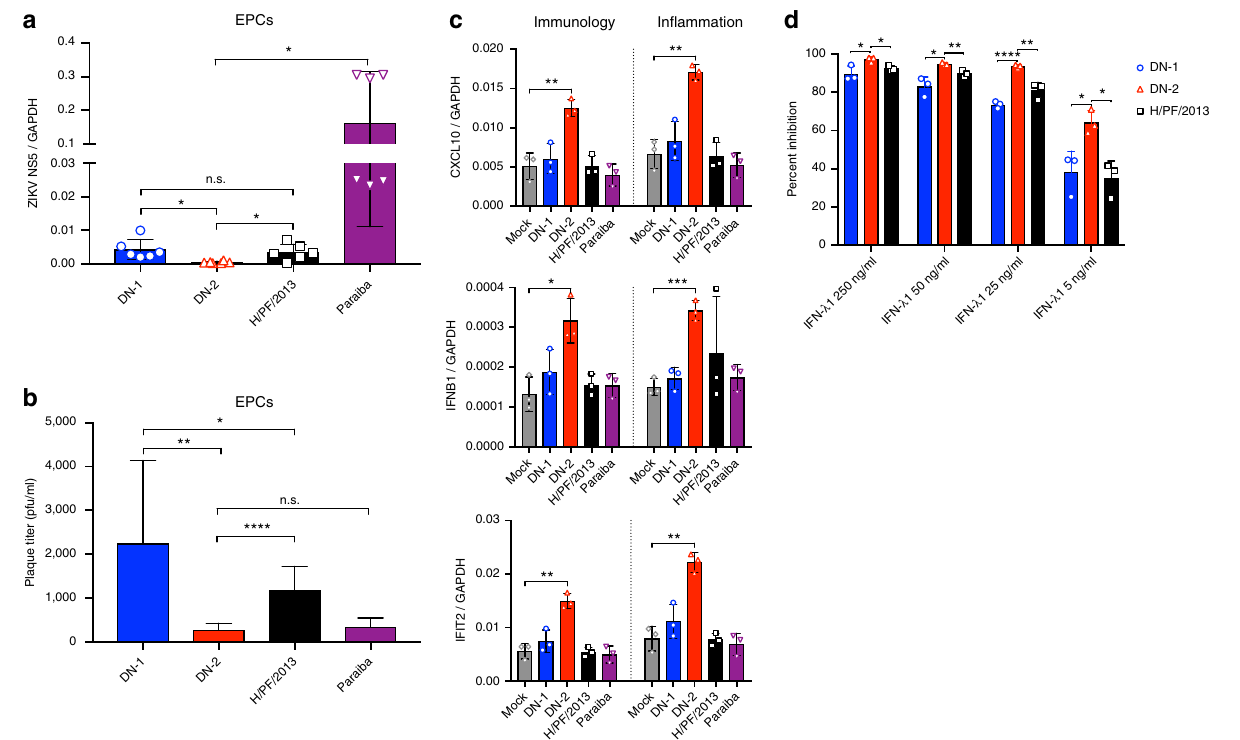
Fig. 5 Attenuated infectivity on endothelial progenitor cells is accompanied by innate immune activation and interferon sensitivity. Viral replication of different ZIKV strains in human embryonic stem cell-derived endothelial progenitor cells (hESC-derived EPCs) was determined by a qPCR ( n = 6) and b plaque assay ( n = 9) (results are combined from three experiments). c NanoString nCounter analysis was performed on infected EPCs at 24 h post infection ( n = 3) using both the Immunology and In fl ammation prebuilt panels. Counts obtained for CXCL10, IFNB1, and IFIT2 were normalized to GAPDH counts. d Percent inhibition of virus replication as determined by viral RNA qPCR on Vero culture supernatant after 48 h of infection with co-treatment at different concentrations of IFN- λ 1 ( n = 3 per data point, representative data of two experiments). See also Supplementary Fig. 3. Error bars represent s.d. * p < 0.05, ** p < 0.01, *** p < 0.001, **** p < 0.0001 in unpaired t test. n.s. not signi fi cant